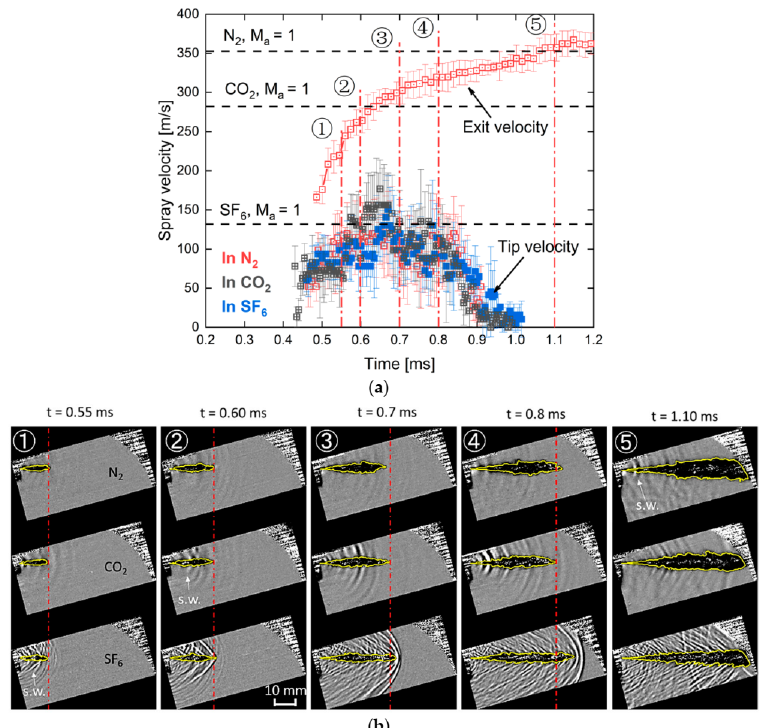
Figure 9. Spray velocity ( a ) and the shock-wave generation vs. time ( b ); ambient gas conditions: 297 K and 9.0 kg / m 3 ; injection pressure: 65 MPa. ‘s.w.’ stands for the shock wave. The red dash-dot line represents the spray leading edge of CO 2